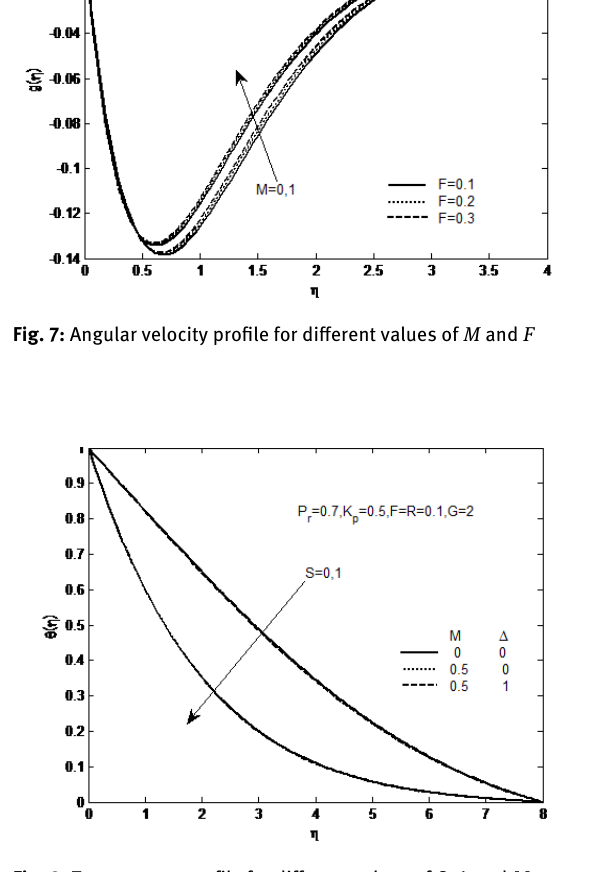
Fig. 7 illustrates the effect of M and F on angular ve-